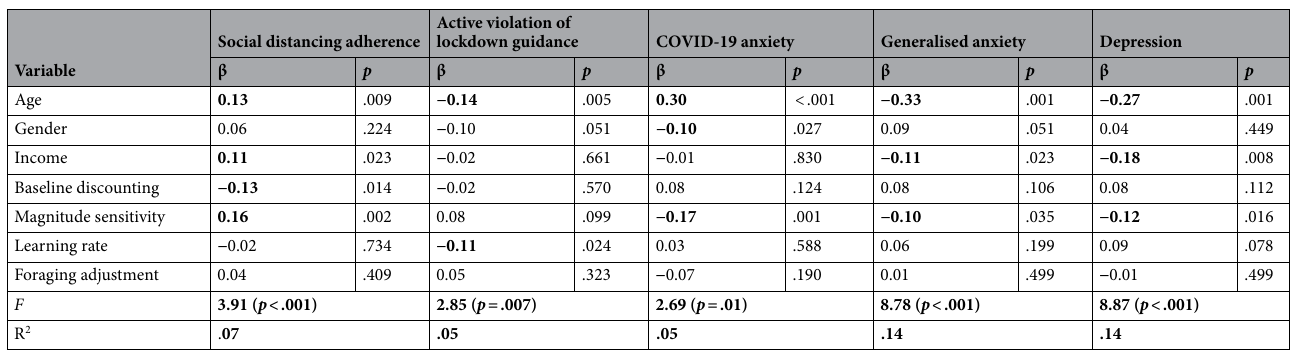
Table 1. Regression model statistics for each of the outcome variables. Bold indicates p < .050. Gender was coded as male = 1 and female = 0. Analyses that were not pre-registered were adjusted to correct for multiple